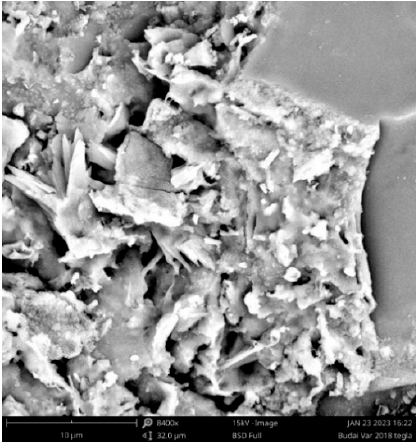
Figure 3. SEM image of a modern brick .